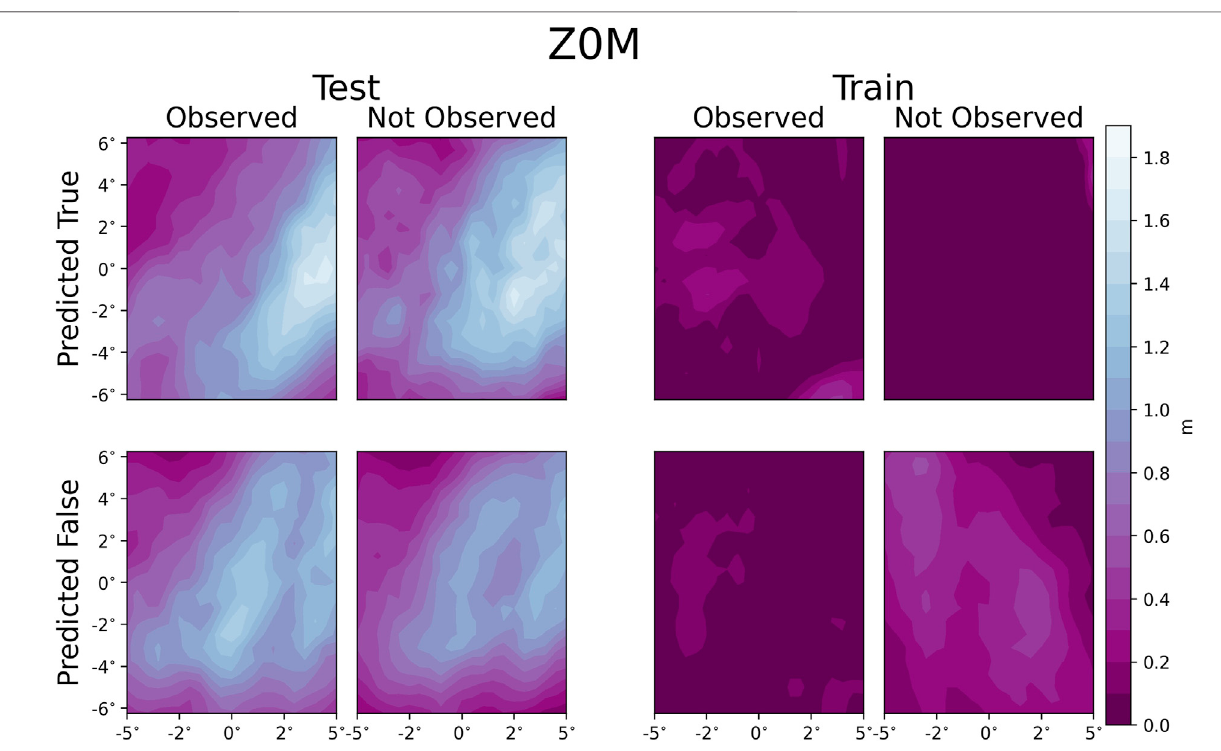
Frontiers in Earth Science |